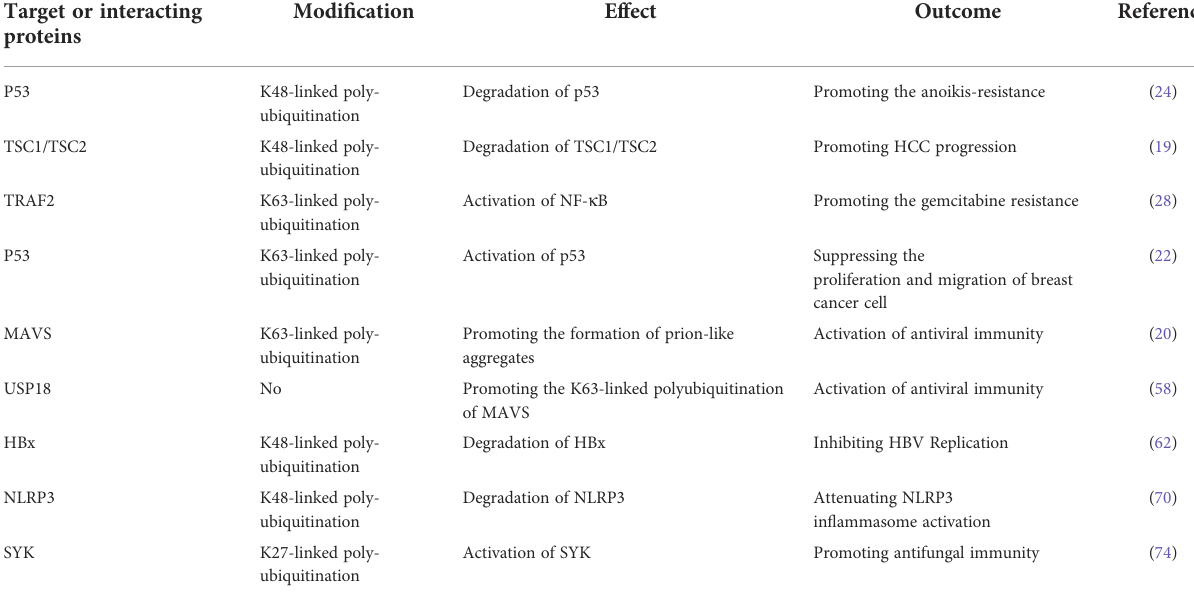
TABLE 1 The TRIM31 targets or interacting proteins. Target or interacting